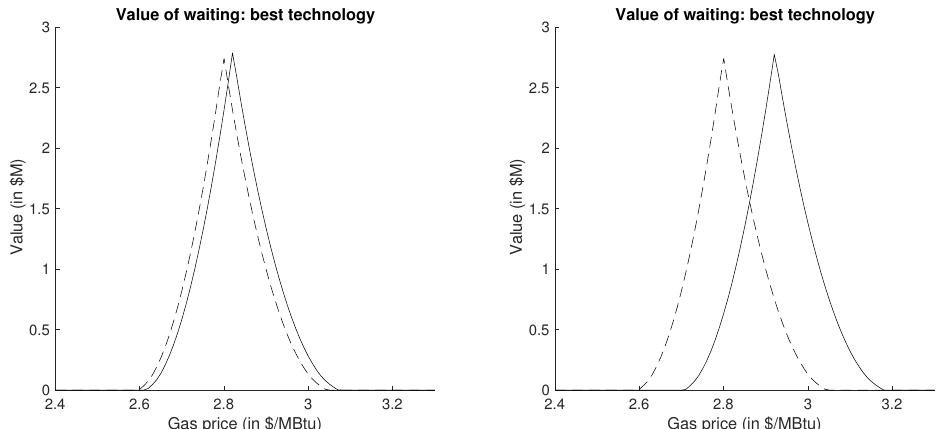
Figure 6. This figure displays the value of waiting to invest (as a function of Y ) in the best of the two technologies at t = 0 in case of low sensitivity of the gas price ( C = 0, left panel ) and of high sensitivity ( C = 2.5, right panel ). The value of X t is 150$/MWh. Solid line corresponds to the pandemic case, dashed line to the no-pandemic case. Parameter values are given in Table 1; the investment horizon is T = 1